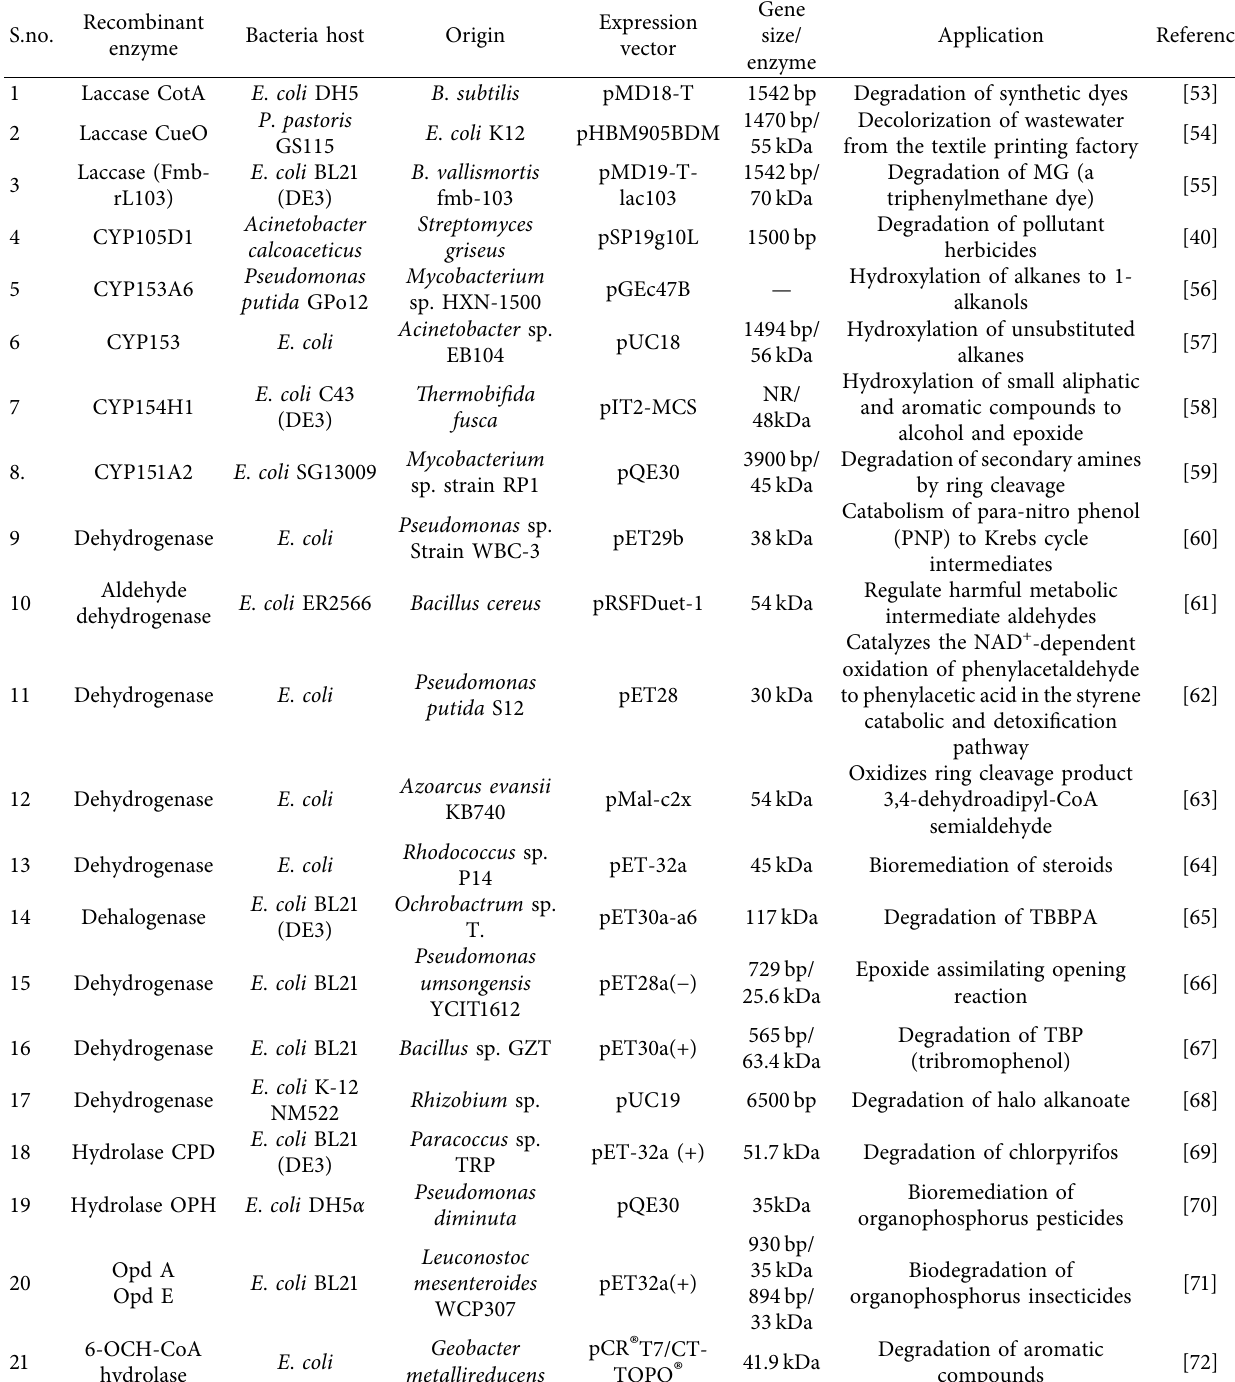
Table 3: Microbial enzyme produced by recombinant DNA technology for enhanced bioremediation.